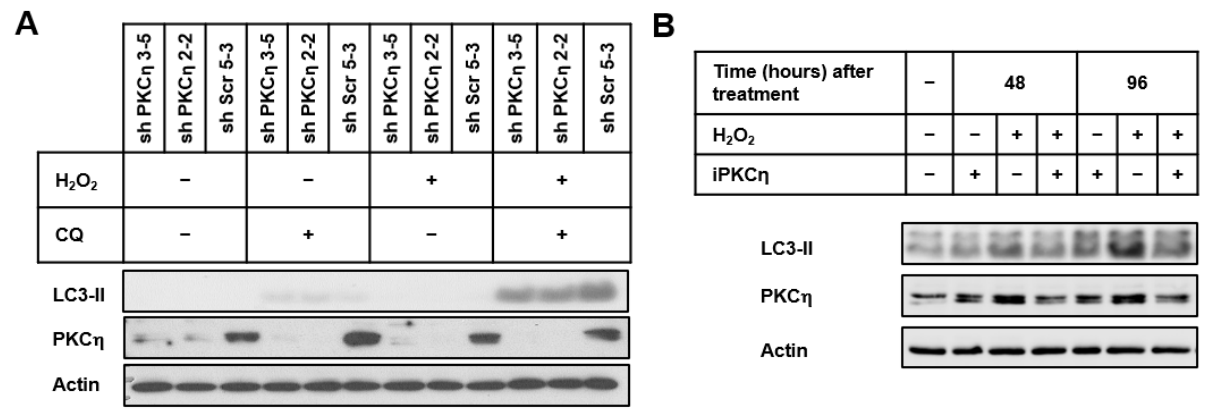
Figure 2. PKC η knockdown reduces oxidative stress-induced autophagy. ( A ) Sub-confluent MCF-7 stably transfected with shRNA constructs (shPKC η 3-5, shPKC η 2-2) or scrambled control plasmid (shScr5-3) were treated with CQ (10 µ M) for 1 h in serum-free medium, followed by H 2 O 2 (150 µ M) for 2 h. Fresh growth media were replaced for 96 h. ( B ) Sub-confluent MCF-7 cells were treated with an inhibitory peptide for PKC η (iPKC η ) for 4 h in serum-free medium, followed by treatment with H 2 O 2 (150 µ M) for 2 h. Fresh growth medium was replaced for 48 h and 96 h. At the end of the experiments, whole-cell lysates were prepared and subjected to immunoblotting with indicated antibodies. Actin was used as the loading control. Results are representative of three independent